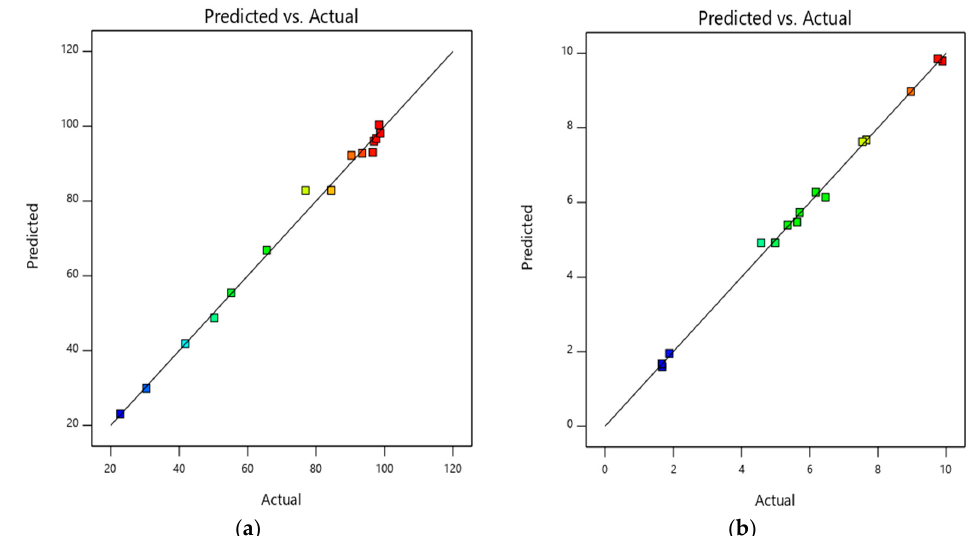
Figure 4. Correlation between predicted and actual values for ( a ) sulphate reduction efficiency and ( b ) sulphate reduction rate.